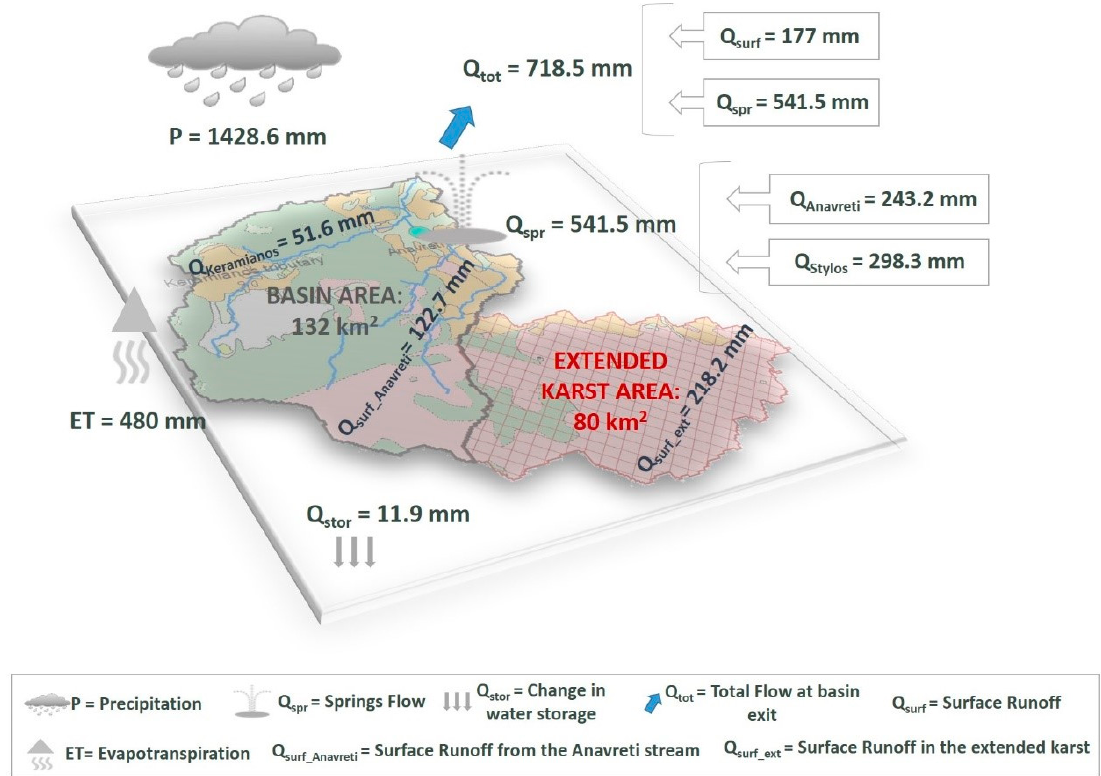
Figure 5. Mean annual hydrologic budget of the Koiliaris CZO.